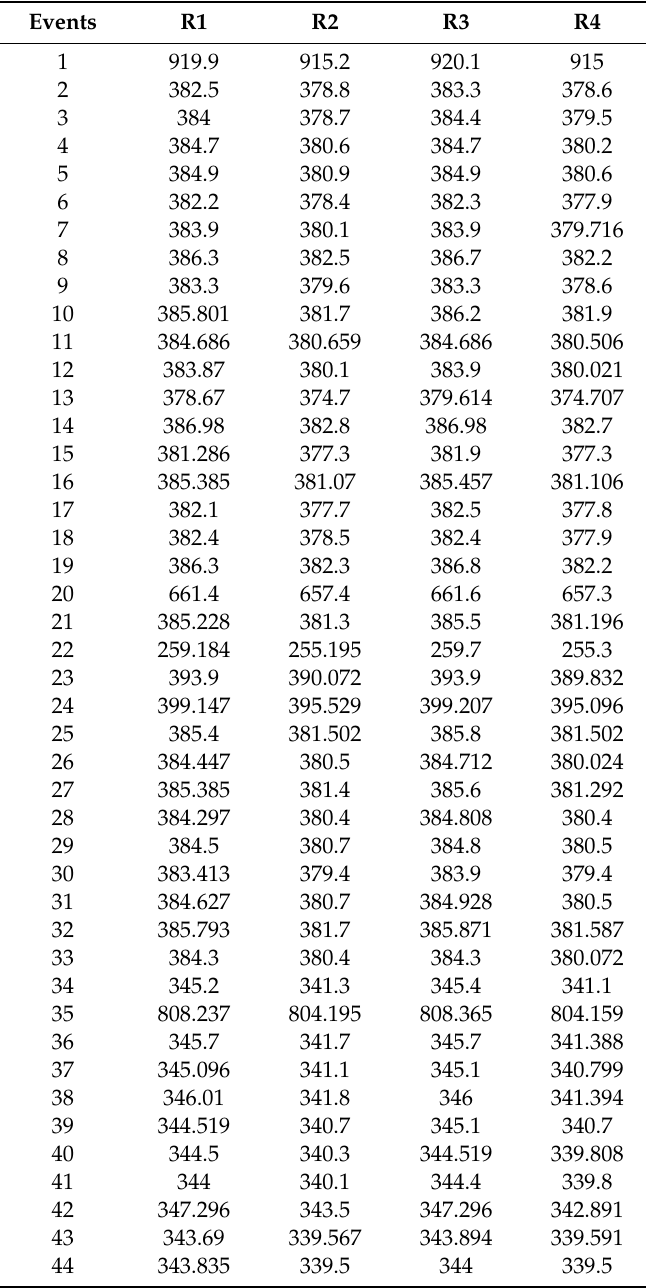
Table A1. Arrival Times of the 44 Microseismic